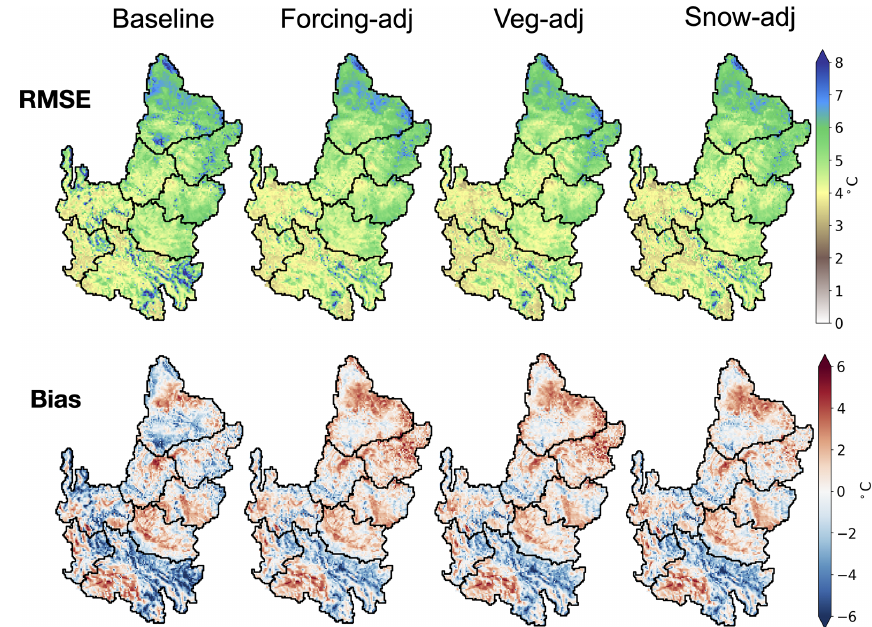
Figure 9. Spatial maps of the RMSE and bias between time series of nighttime LST V and LST M during 2003–2018 at each pixel for all steps. Top (bottom) row presents results of RMSE (bias).